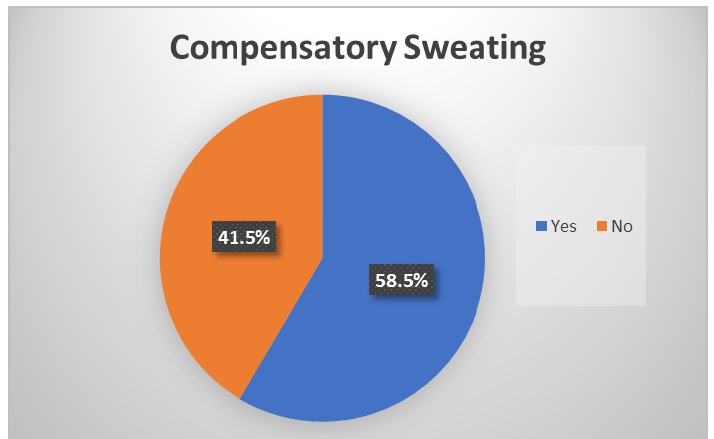
severity.Figure 3. Distribution of patients reporting compensatory